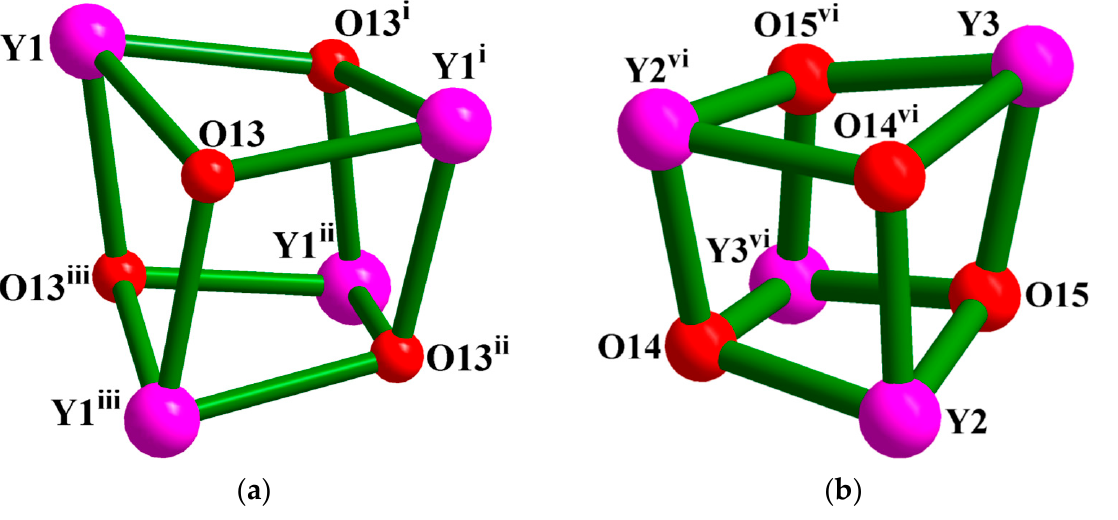
Figure 3. ( a ) The Y1-containg quadnuclear {Y 4 O 4 } cluster secondary building unit; ( b ) The Y2-Y3- containg quadnuclear {Y 4 O 4 } cluster secondary building unit. Interestingly, all {Y 4 O 4 } clusters can be joined by eight monodentate {Y 4 O 4 } manner carboxyl groups (Figure 4) along a - and b -axis to form an infinite two-dimensional (2-D) organic-inorganic lattice with a − ABAB − mode of a square dimension of 18.07(3) × 18.07(3) Å 2 (the center separation of A and B). Furthermore, these 2-D nets are linked to four bidentate {Y 4 O 4 } manner carboxylate radicals and stacked to each other with a − AAAA − or a − BBBB − style of a layer thickness of 7.94(3) Å (the center separations of A-A and B-B), leading to a three-dimensional (3-D) metal-organic framework with a one-dimensional (1-D) 18.07(3) × 18.07(3) Å 2 (the center distances between the A and B) square channel along the c -axis or [0,0,1] direction (Figures 5 and S4 from Supplementary Materials).